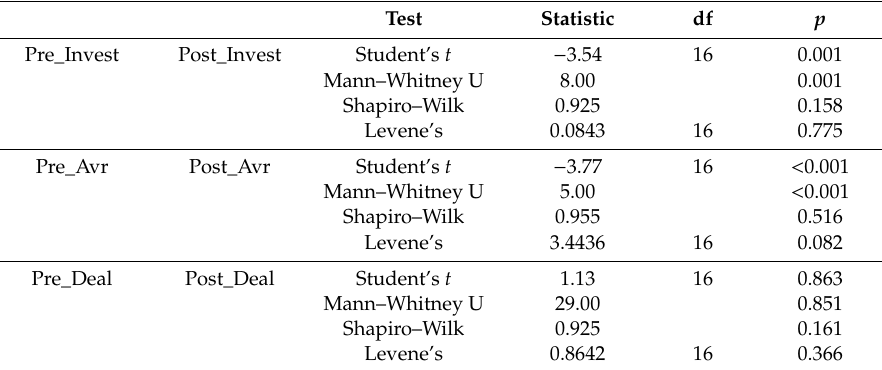
Table 10. The results of the comparison